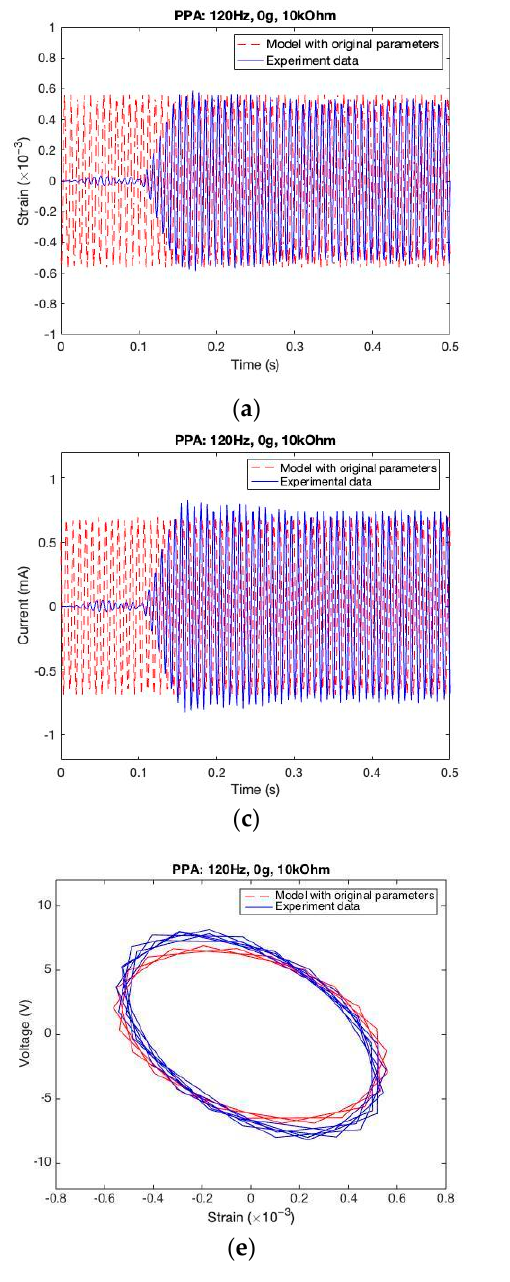
19 of 27 Table 1. Optimal settings of energy harvesters of MFC and PPA . Structural Type